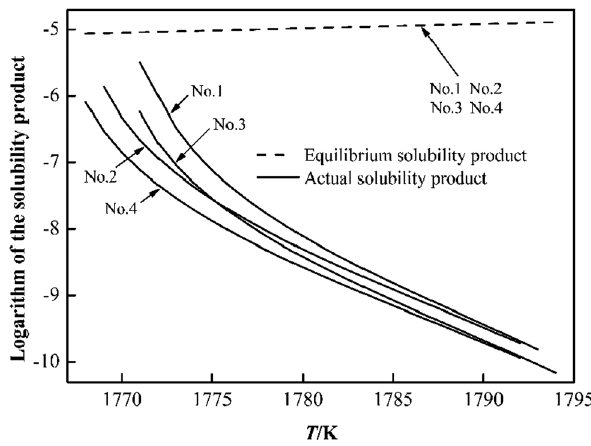
Figure 9: Logarithm of the solubility product as a function of temperature for MnS in the solid phase at the solidification